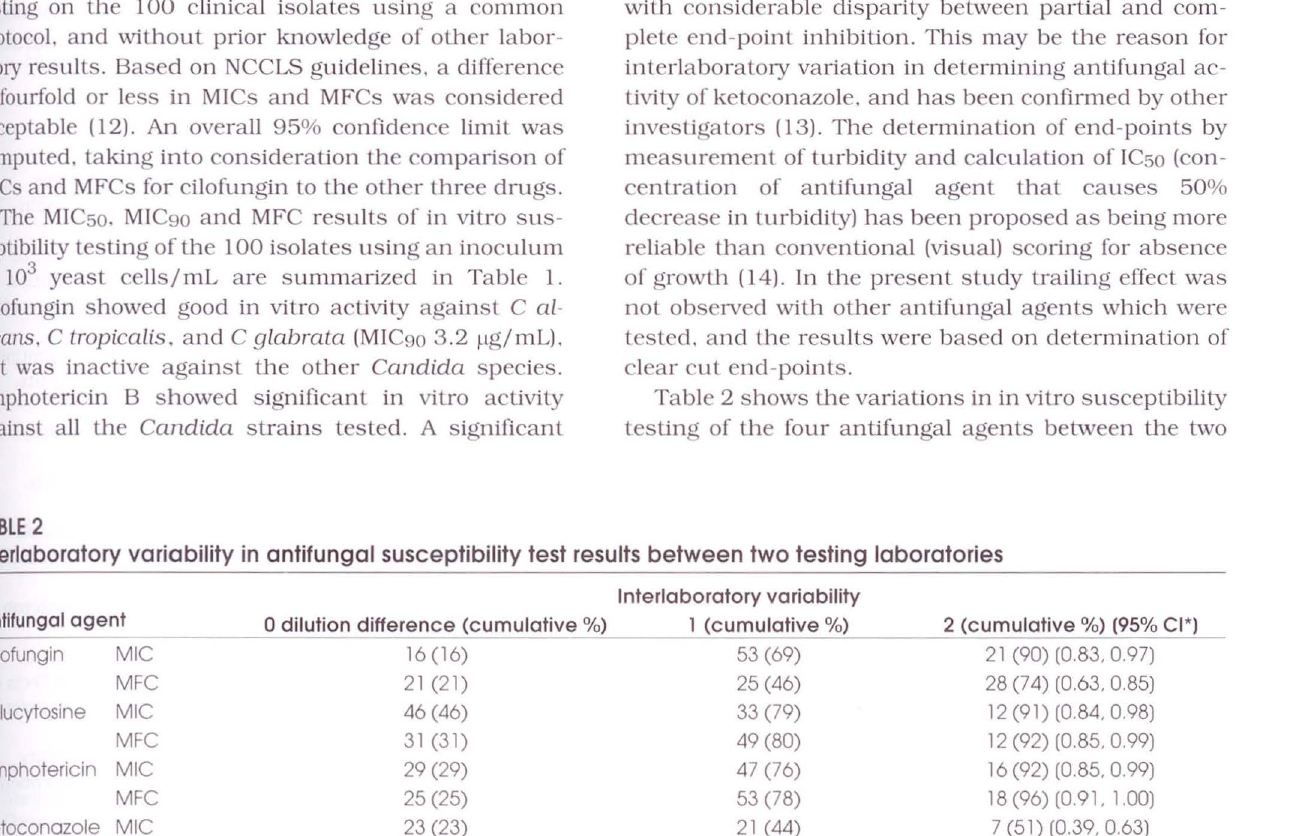
Interlaboratory variability